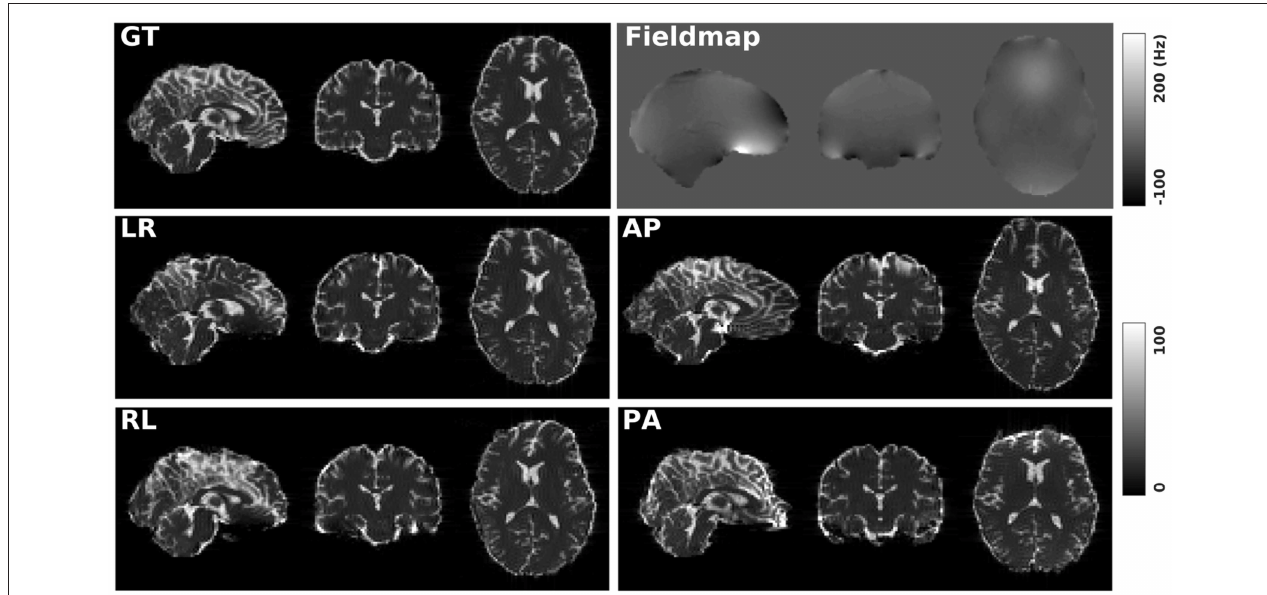
FIGURE 1 | GT: simulated diffusion data (without distortions) for HCP subject 100206. Fieldmap: the real fieldmap used to simulate the distortions. LR: simulated diffusion data with LR distortion. RL: simulated diffusion data with RL distortion. AP: simulated diffusion data with AP distortion. PA: simulated diffusion data with PA distortion.